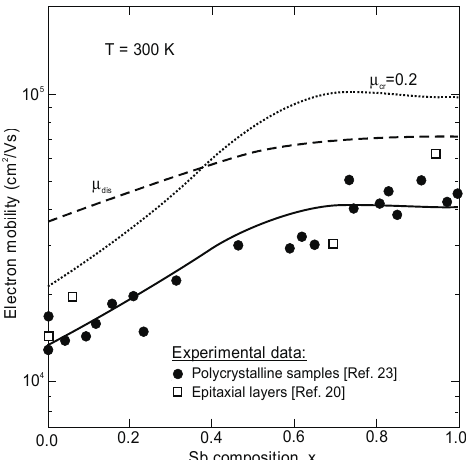
Figure 14. InAs 1 − x Sb x electron mobility composition dependence for room-temperature (solid lines [77]) and carrier concentration of 10 17 cm − 3 with a compensation ratio of 0.2 and the effects of a dislocation density of 3.8 × 10 8 cm − 3 . The experimental data is taken after [20,23] for samples with electron concentrations above 10 16 cm − 3 .